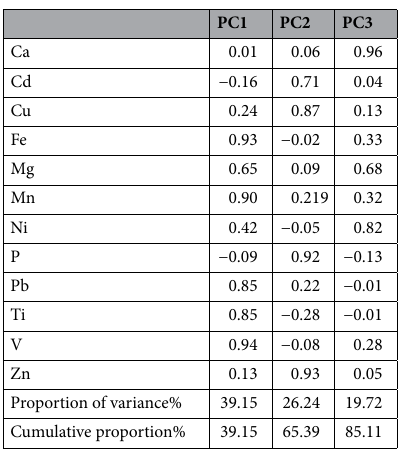
Table 4. Loadings of elements on VARIMAX-rotated factors of different datasets.